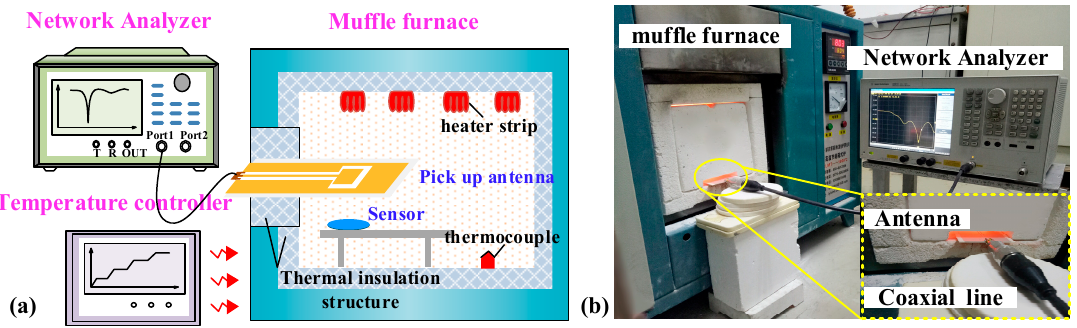
Figure 7. ( a ) Schematic of the high ‐ temperature testing platform. ( b ) Measurement set up.